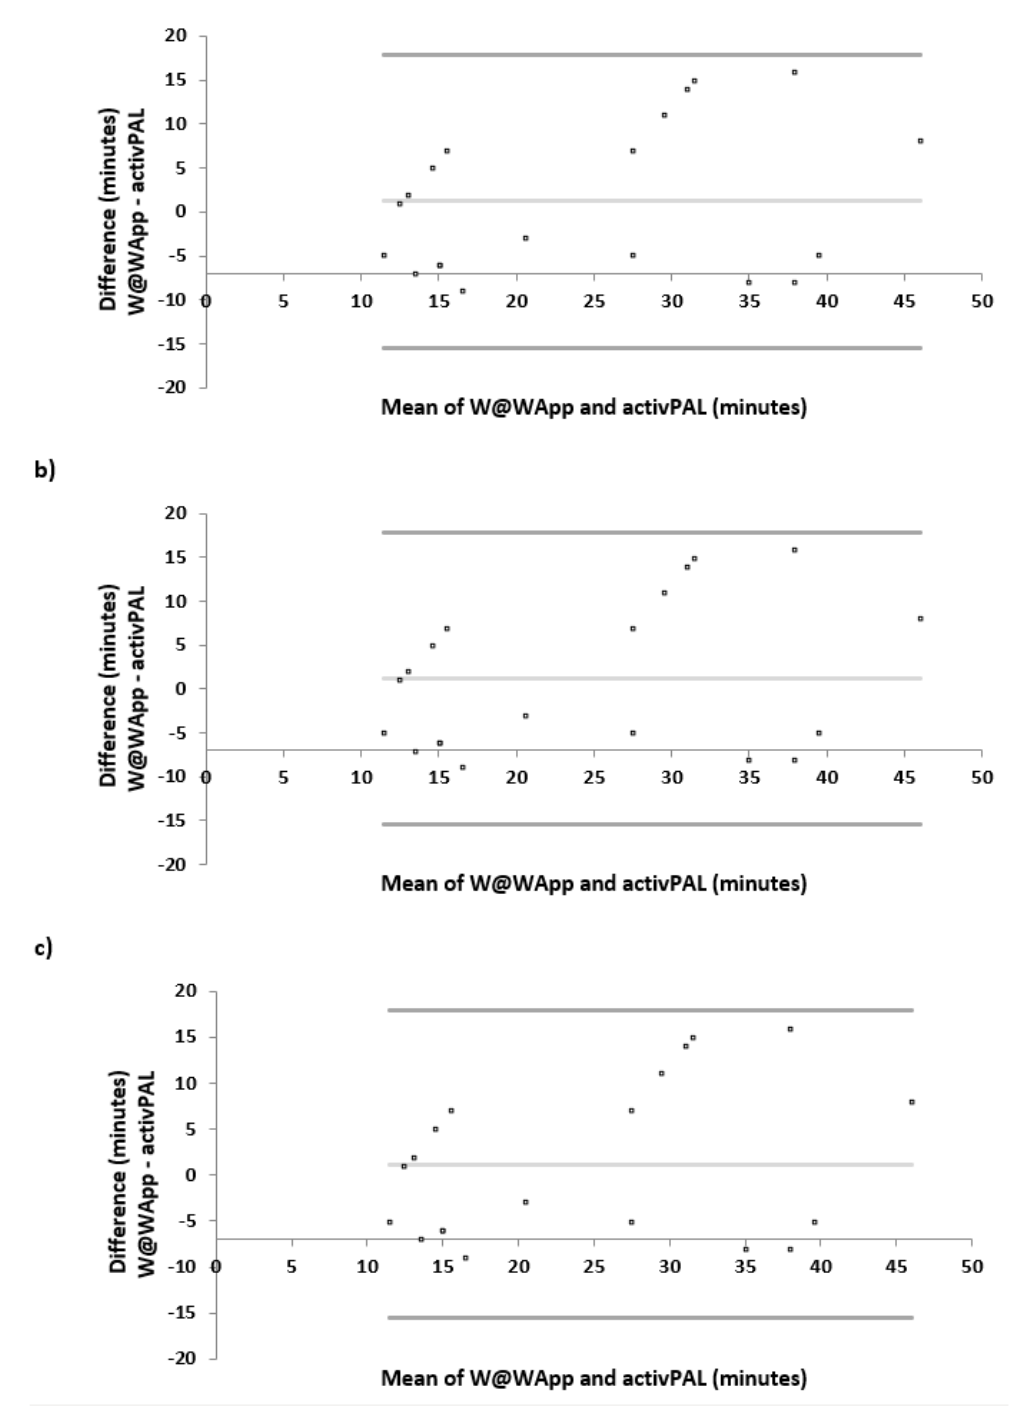
Figure 3. Bland-Altman plots of absolute agreement for (A) sitting, (B) standing, and (C) stepping, derived from the W@W-App+MetaWearC with the equivalent outcome derived from the